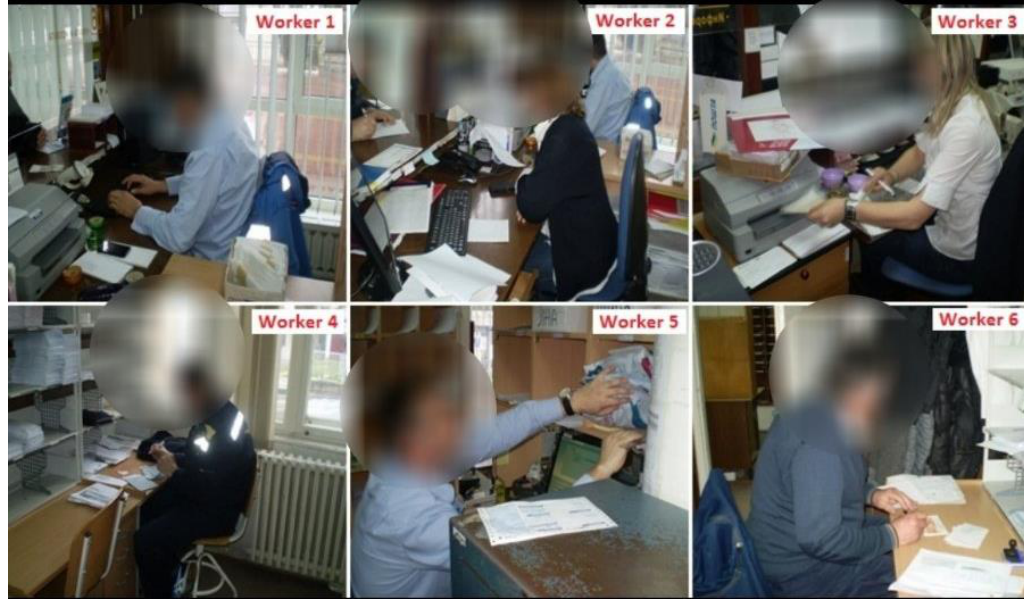
Figure 3. Photos from the considered work stations. Source: (Authors).